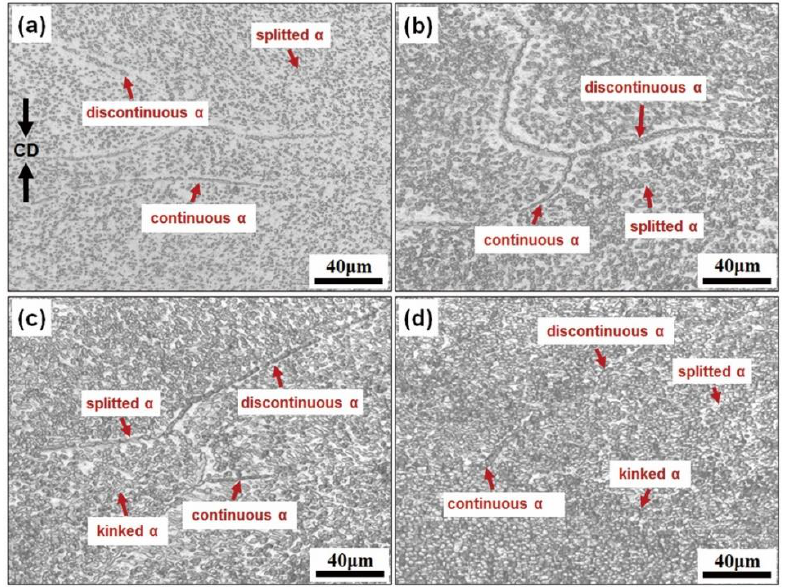
Figure 4. OM images of TB18 alloy deformed in the (α + β) phase zone: ( a ) 700 °C/0.001 s − 1 , ( b ) 700 °C/0.01 s − 1 , ( c ) 750 °C/0.01 s − 1 , ( d ) 750 °C/0.1 s − 1 .